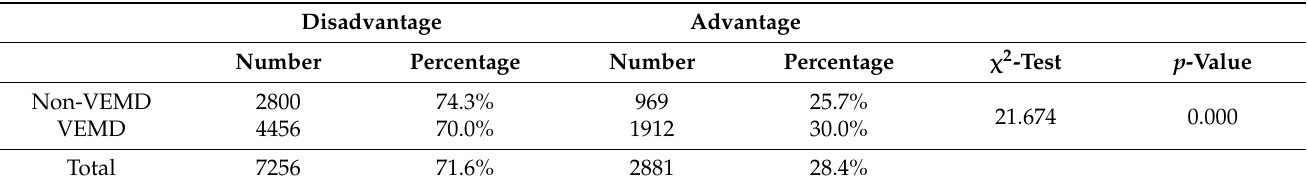
Table 2. Comparing Non-VEMD and VEMD Reporting Hospital presentations for children from areas of Disadvantage and Advantage (according to IRSD). Disadvantage Advantage Number